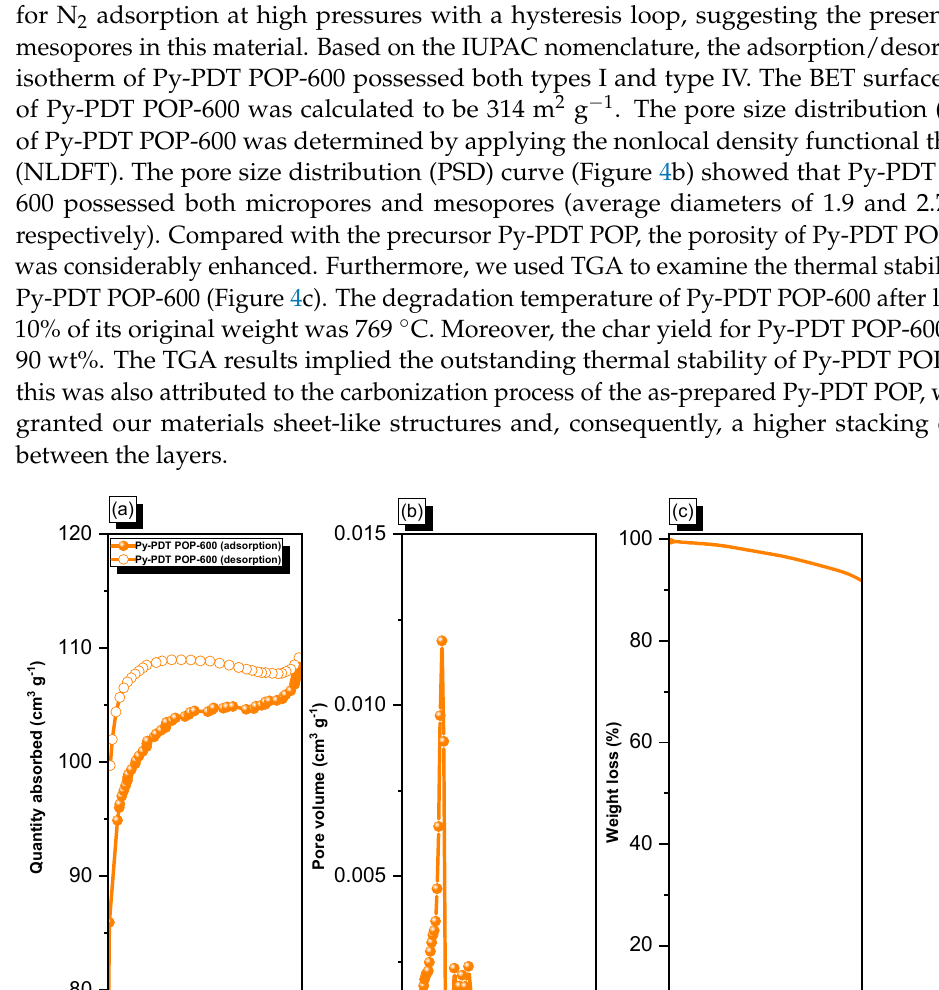
Figure 3. SEM ( a – c ), EDS-SEM ( d – g ), and TEM ( h , i ) images of Py-PDT POP.